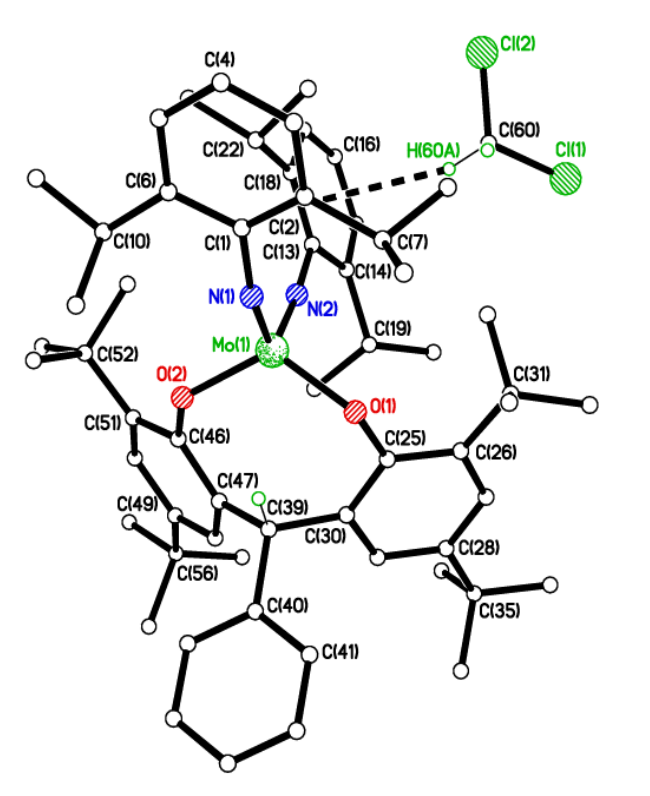
Figure 2. Crystal structure of [Mo(NC 6 H 3 i -Pr 2 -2,6) 2 L 1Ph ]·CH 2 Cl 2 ( 2 ·CH 2 Cl 2 ), showing the atom numbering scheme. Selected bond lengths (Å) and angles (°): Mo(1)–N(1)